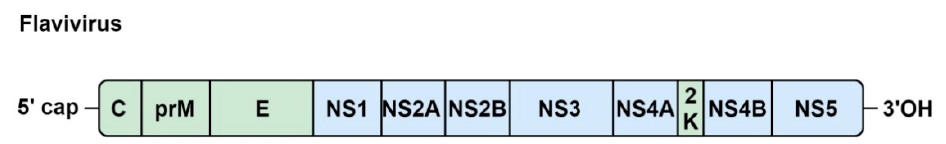
Figure 4. Genome organization of flaviviruses. The genome encodes one ORF, which contains the seven nonstructural proteins (NS) and the structural proteins (C, capsid; prM, premembrane; E, envelope). Blue and green indicate the nonstructural and structural proteins, respectively.